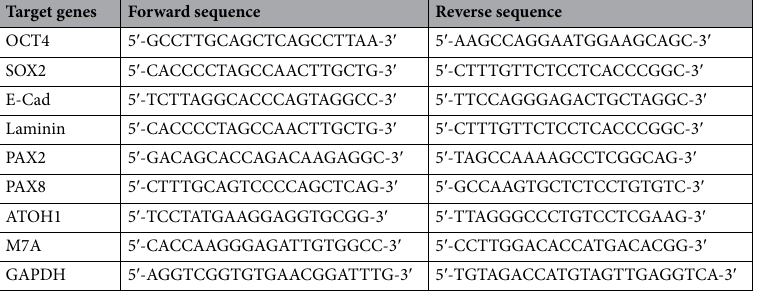
Table 2. List of primers used for the qRT-PCR analysis of co-cultured embryonic